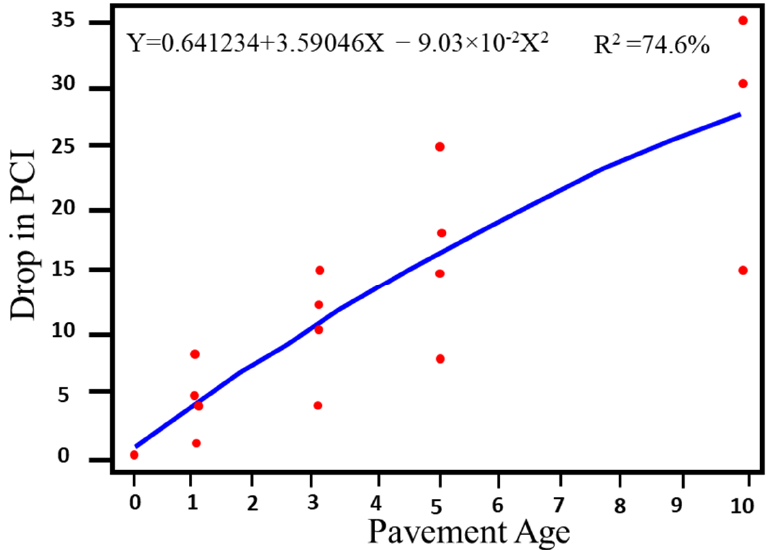
Figure 5. Effect of the no maintenance strategy on the deterioration of PCI for low traffic.